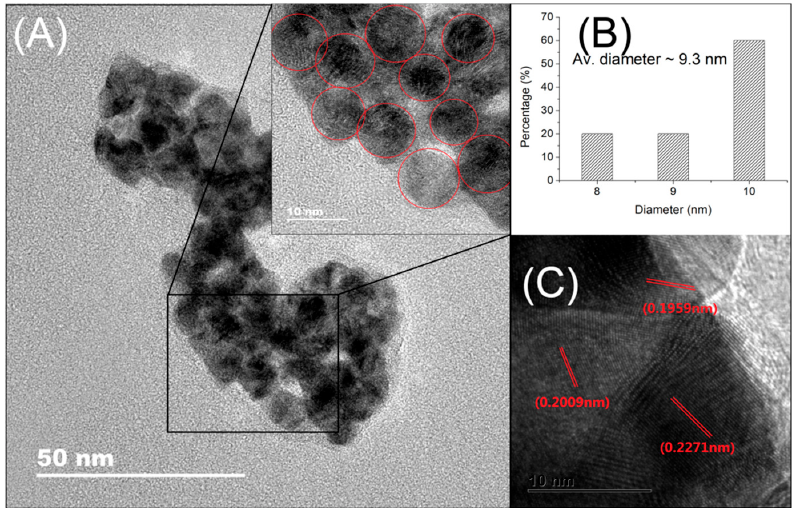
Figure Figure 3 . ( A ) TEM image of Pd/Cu@AC; ( B ) particle-size distribution evaluated from ( A ); ( C ) high- resolution TEM (HRTEM) image of a part of ( B ).